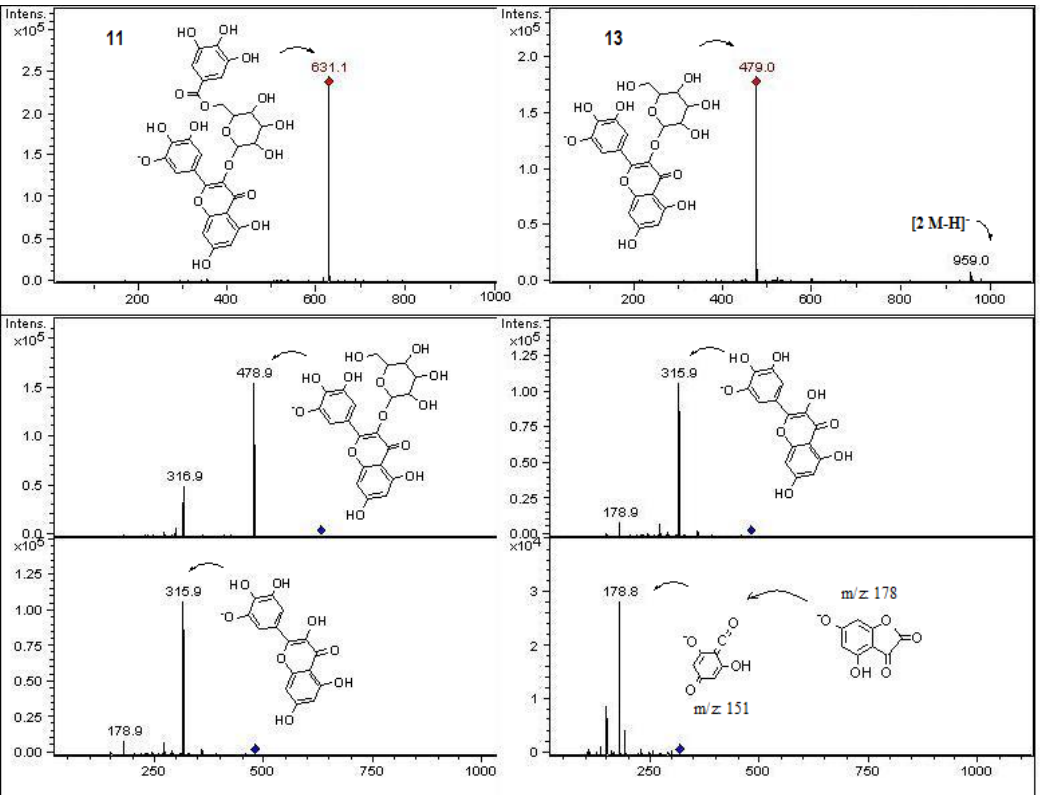
Figure 7. Structures, fragmentation, full ESI-MS and MS-MS spectra of peaks 11 and 13